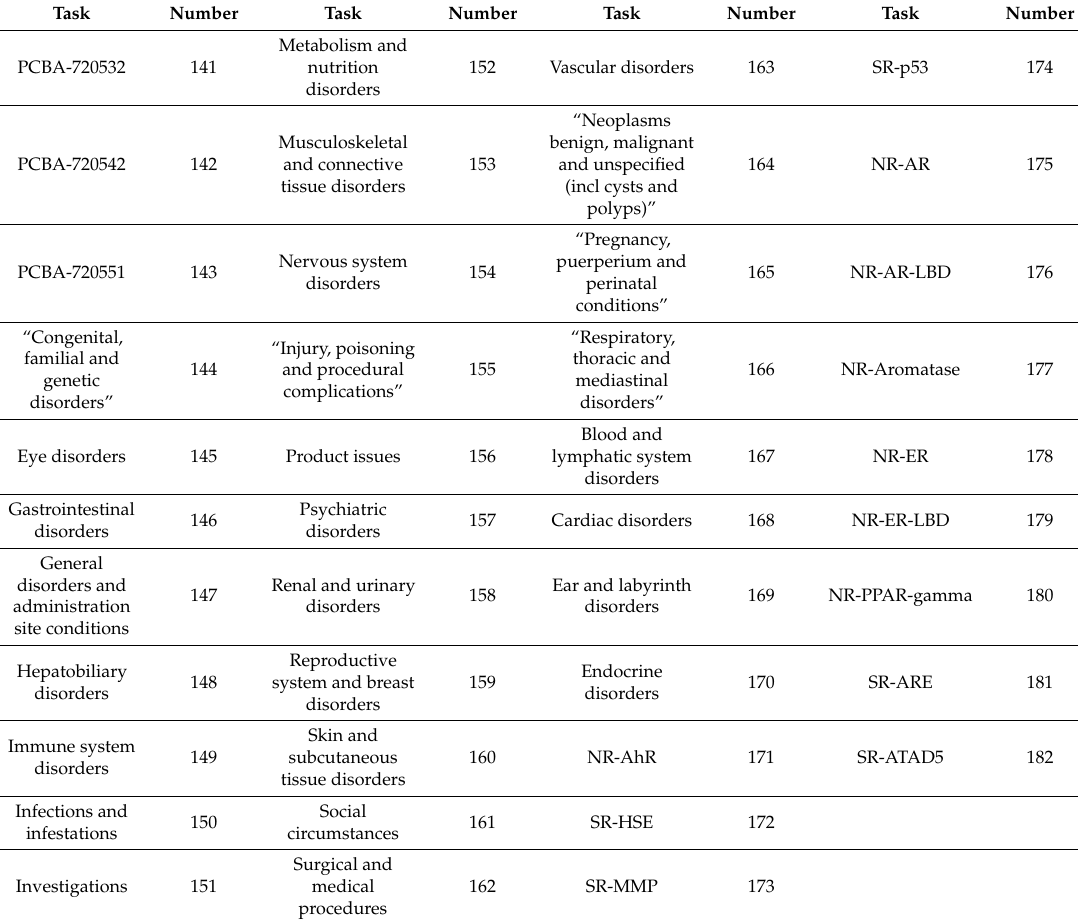
Table A3. Source tasks and their referred number within the figures, part